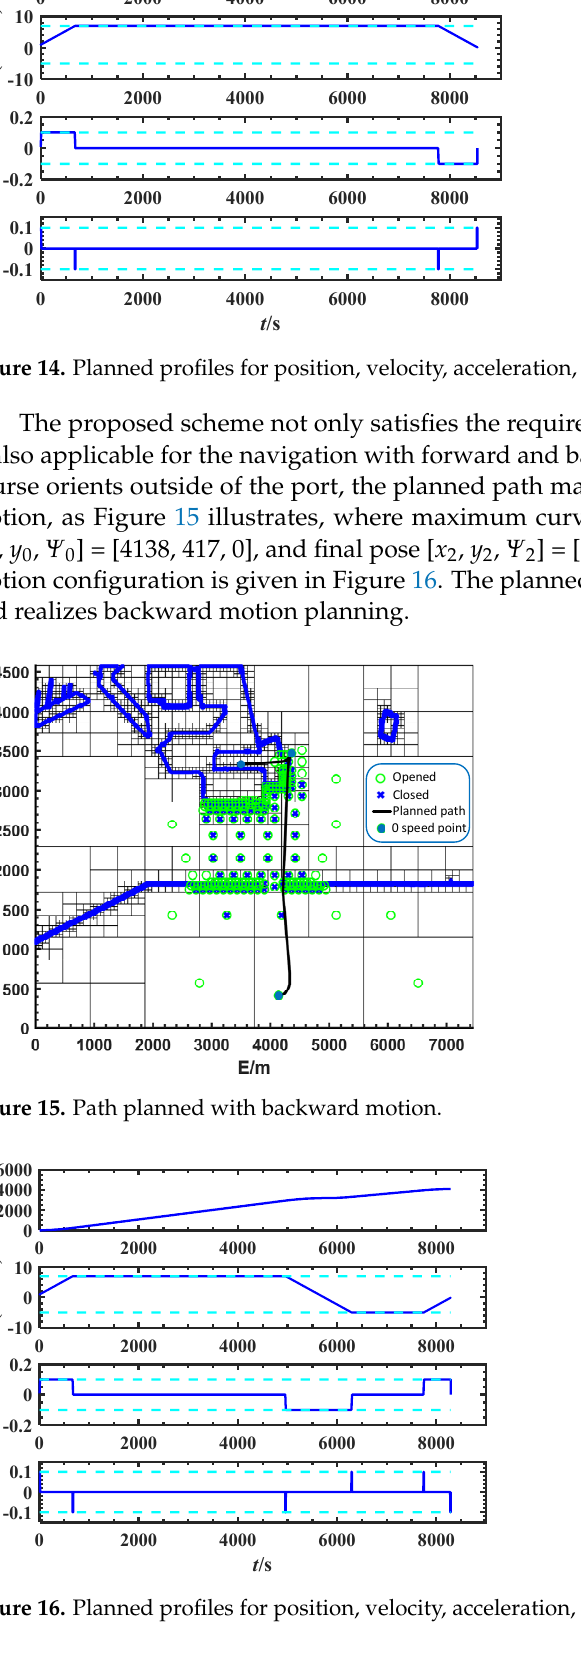
Figure 13. Planned trajectory with proposed scheme.